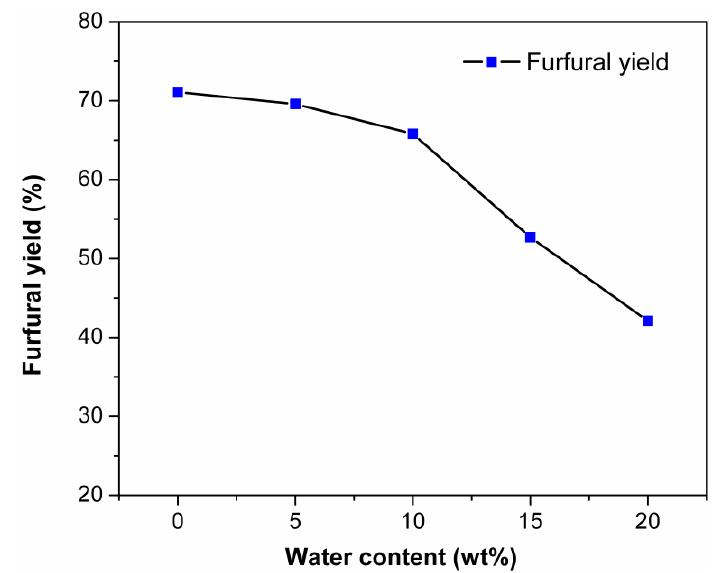
Figure 8. Effect of water content on the dehydration of xylose into furfural. Reaction conditions: 1000 mg of (EMIMBr + H 2 O); molar ratio of SnCl 4 :xylose = 1:10; 130 °C; 1 h.